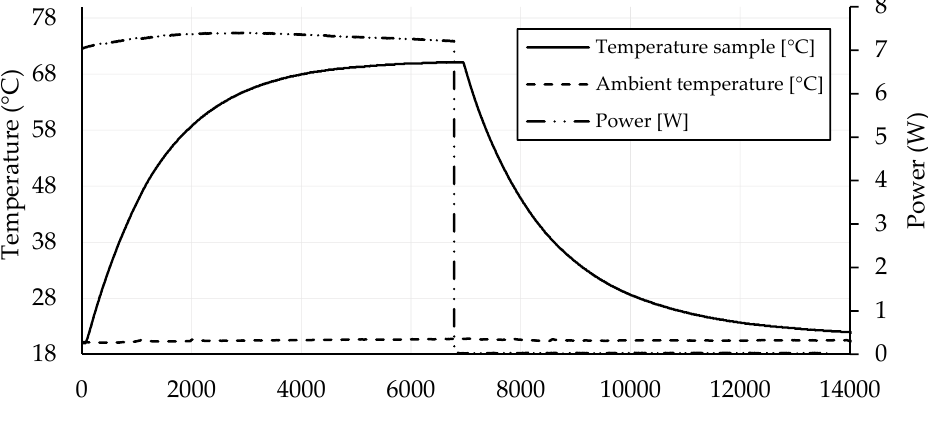
Figure 12. Self-heating experiment—CB 2, 100 V.